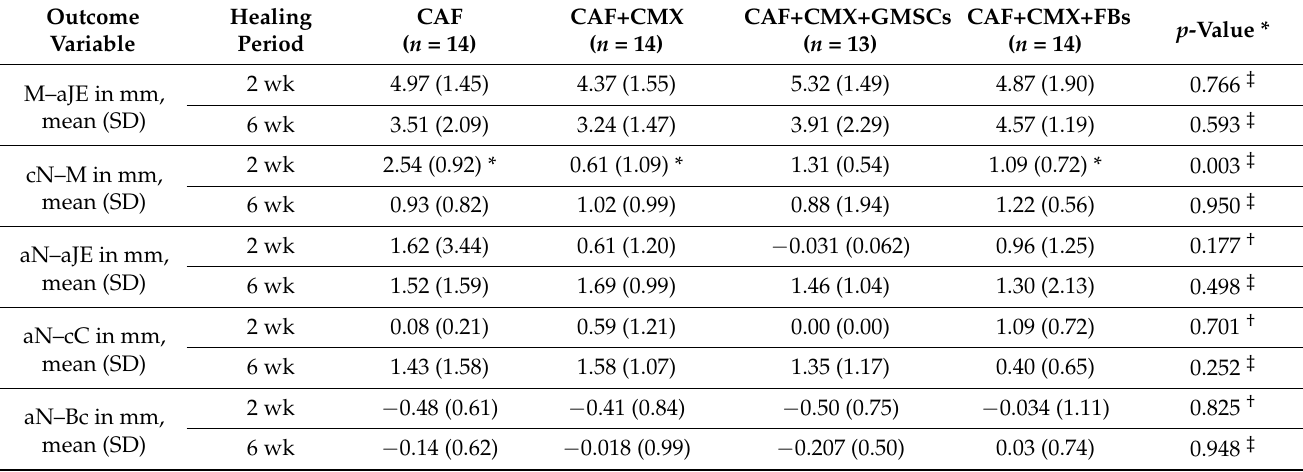
Table 1. Histometric measurements at the 2- and 6-week healing